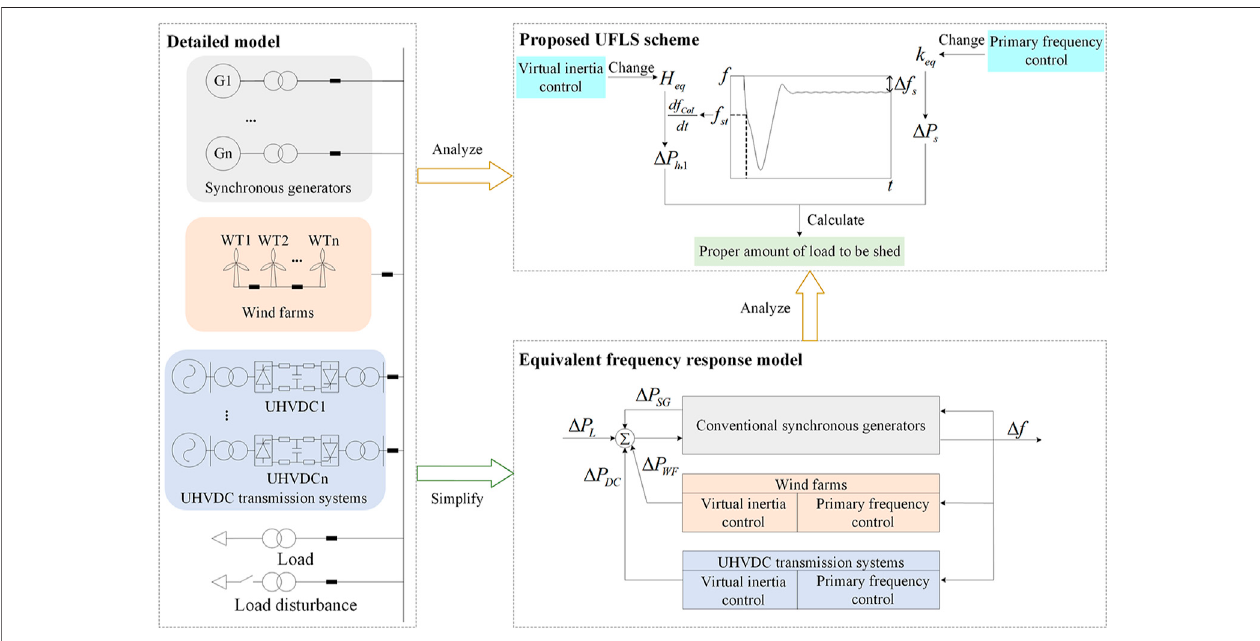
FIGURE 1 | Overall scheme of the proposed UFLS control